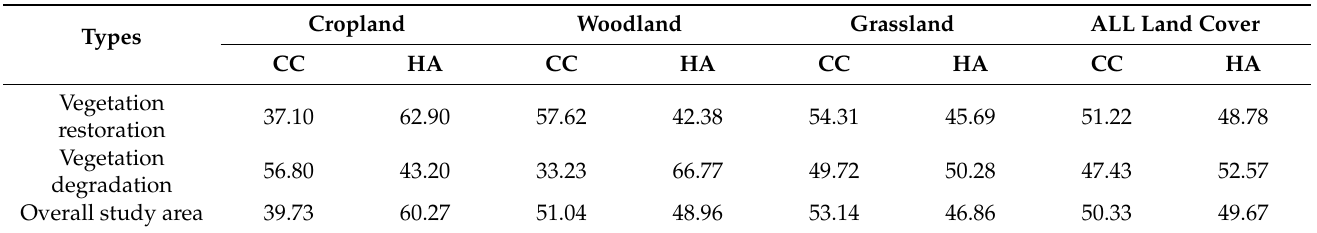
Figure 9. The relative contribution of climate change ( a ) and human activities ( b ) to vegetation change, and the spatial distribution of driving forces of vegetation dynamics ( c ). (ICH: NDVI increase caused by climate change and human activity; IHA: NDVI increase caused by human activity; ICC: NDVI increase caused by climate change; DCH: NDVI decrease caused by climate change and human activity; DCC: NDVI decrease caused by climate change; DHA: NDVI decrease caused by human activity). Table 6. The contribution rate of climate change (CC) and human activities (HA) to different types of vegetation dynamics in the study area from 1982 to 2015